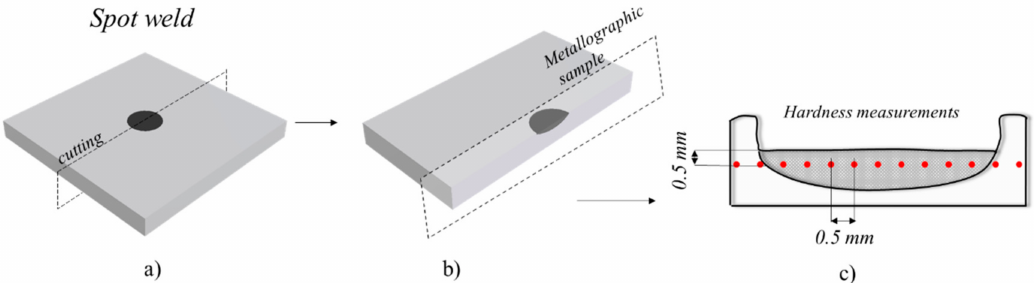
Figure 5. Schematic representation of the samples preparation after welding: ( a ) cutting location, ( b ) metallographic sample and ( c ) hardness measurements